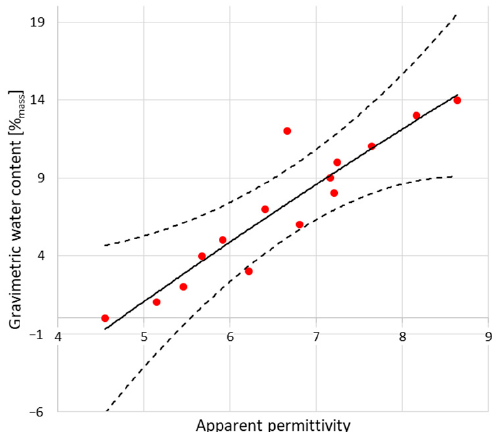
Figure 7. Dependence between relative permittivity readouts using TDR B Sensor and mass moisture evaluated gravimetrically.